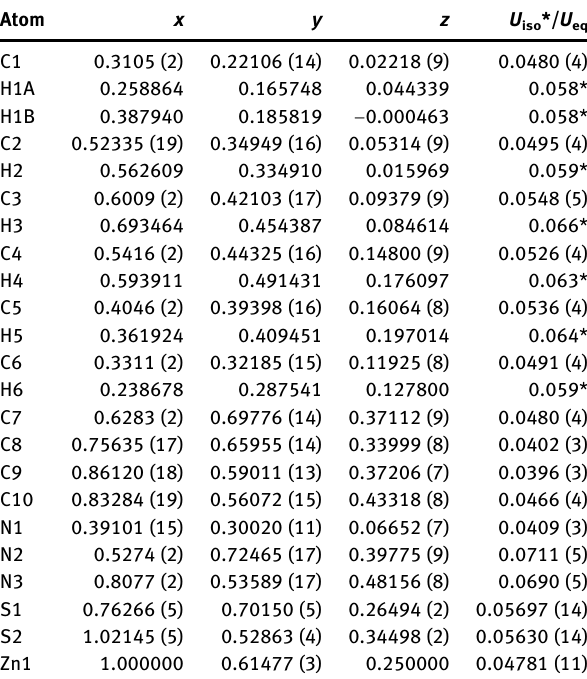
Table  : Fractional atomic coordinates and isotropic or equivalent isotropic displacement parameters (Å 